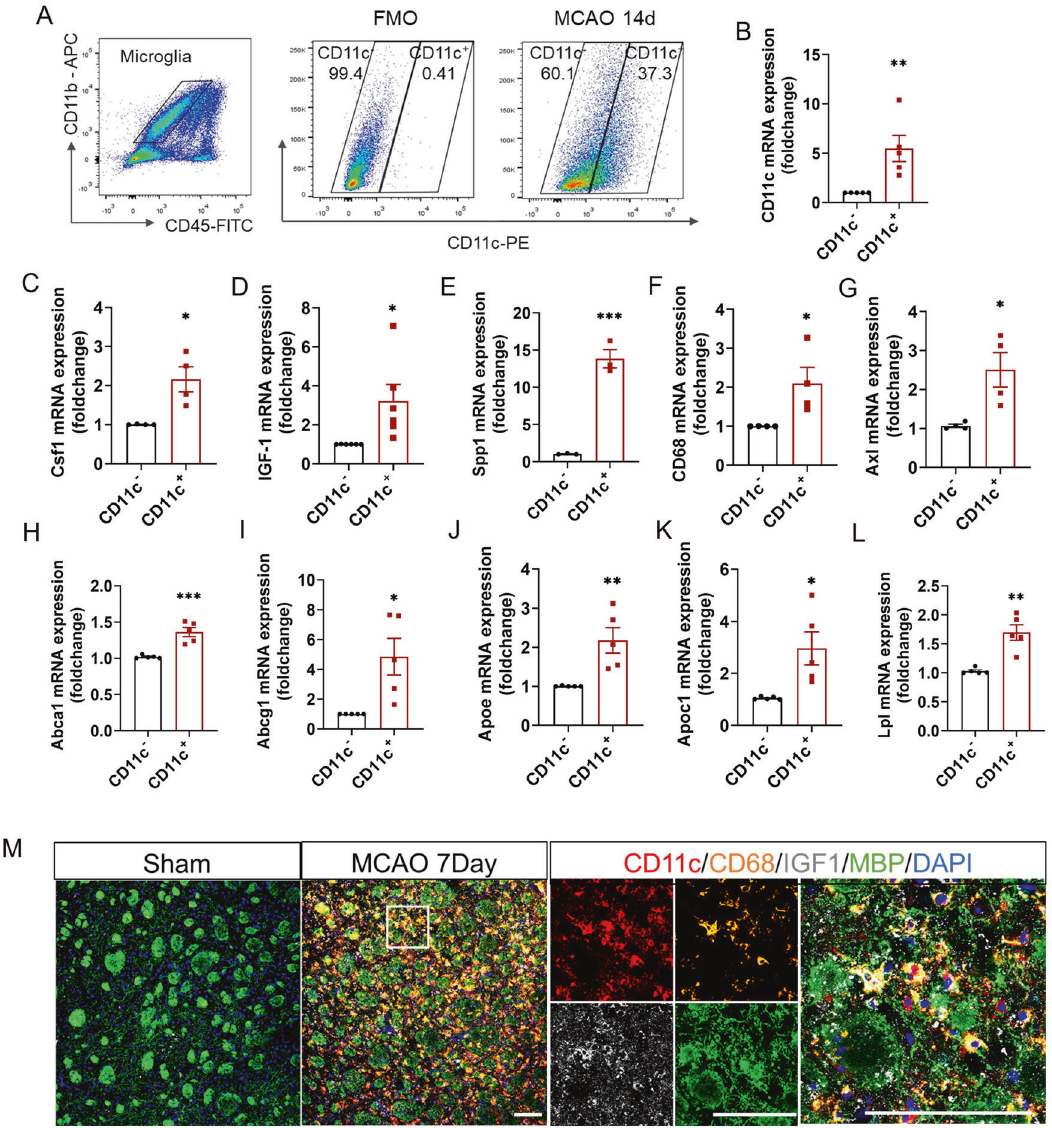
Fig. 5 CD11c + microglia expressed higher phagocytic genes, myelin supportive genes, and lipid metabolism associated genes than CD11c − microglia. A Gating strategy and the fl uorescence minus one (FMO) sample to identify CD11c − and CD11c + microglia on tMCAO 14d. qPCR for CD11c ( B ), Csf1 ( C ), Igf-1 ( D ), Spp1 ( E ), CD68 ( F ), and Axl ( G ) mRNA expression in CD11c − and CD11c + microglia, respectively. n ≥ 3 repeats. The results of qPCR for Abca1 ( H ), Abcg1 ( I ), Apoe ( J ), Apoc1 ( K ), and Lpl ( L ) mRNA expression in CD11c − and CD11c + microglia, respectively, on the 7th Day post-stroke. n = 5 repeats. M Representative images of CD11c (red), CD68 (orange), IGF-1 (gray), and MBP (green) immunostaining on the sham group and 7th Day after tMCAO. Scale bars, 100 μ m. * p < 0.05, ** p < 0.01, and *** p < 0.001. B – L Compared to CD11c - group. Values were mean ±